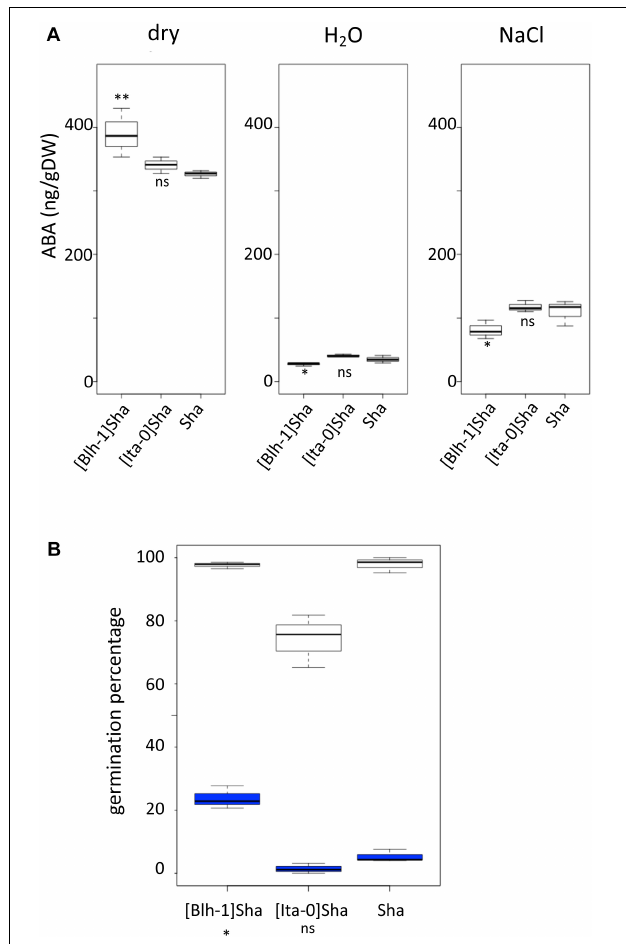
FIGURE 6 | ABA content and sensitivity in seeds from lines of the Sha nucleus series. (A) ABA content of seeds from [Blh-1]Sha, [Ita-0]Sha and Sha genotypes, at the dry stage (left panel), or after stratification followed by 6 h of germination on water (middle panel) or on salt (right panel). Results of comparisons between the cytolines and Sha in the plotted experiment are shown, ∗∗ < 0.01, ∗ < 0.05; ns, not significant. (B) Germination of stratified seeds from [Blh-1]Sha, [Ita-0]Sha and Sha on water (white boxplots) or on 50 µ M ABA (blue boxplots). Germination rate was monitored after 4 days. Results of the test for a different germination response to treatment of each cytoline compared to the parent (significant cytoplasm × treatment effect) are indicated; ∗ p -value < 0.05; ns, not significant (see Supplementary Methods S1 for